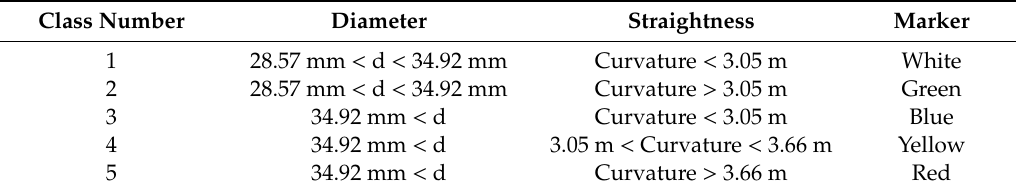
Table 2. Willow tree classification